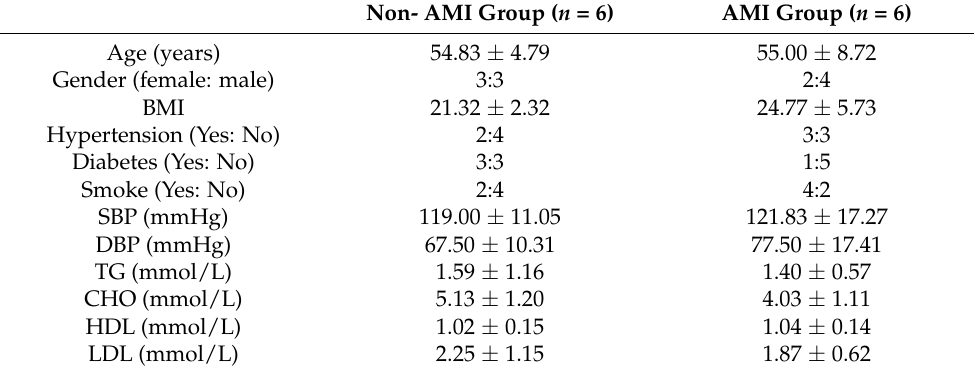
Table 1. Basic demographic and clinical characteristics of patients in two groups ( n =